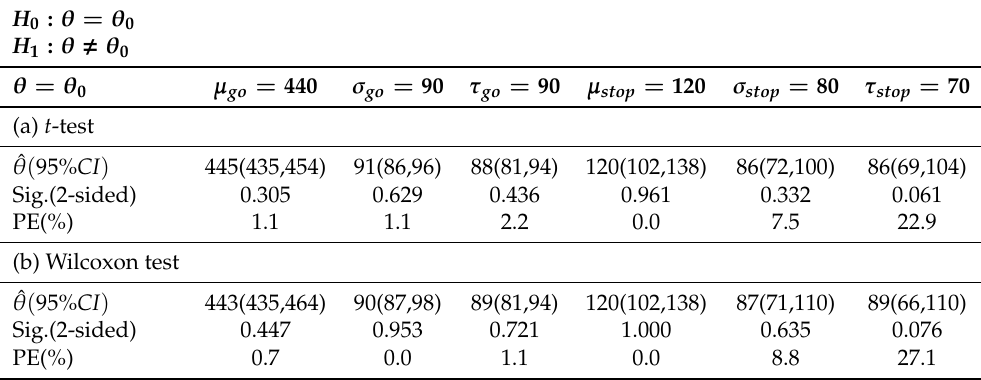
Table 3. A summary of one sample t -test and one sample Wilcoxon signed-ranked test for each of individual parameters ( n =